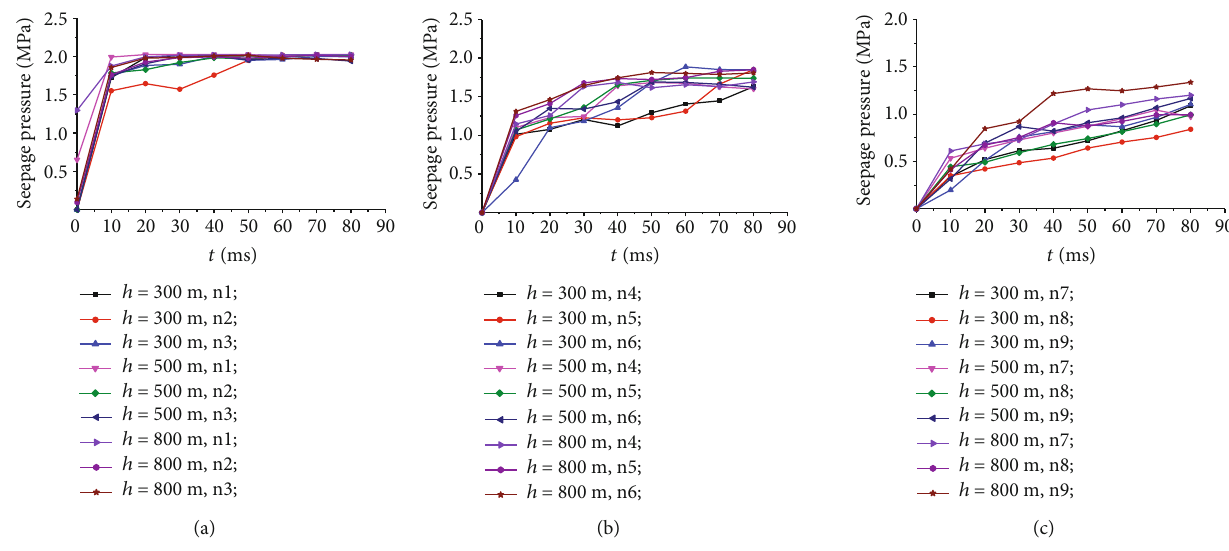
Figure 6: The trend of seepage pressure at the 9 measuring points in the conditions of H = 300 , 500, and 800m: (a) n1 ~ n3 on HL1; (b) n4 ~ n6 on HL2; (c) n7 ~ n9 on